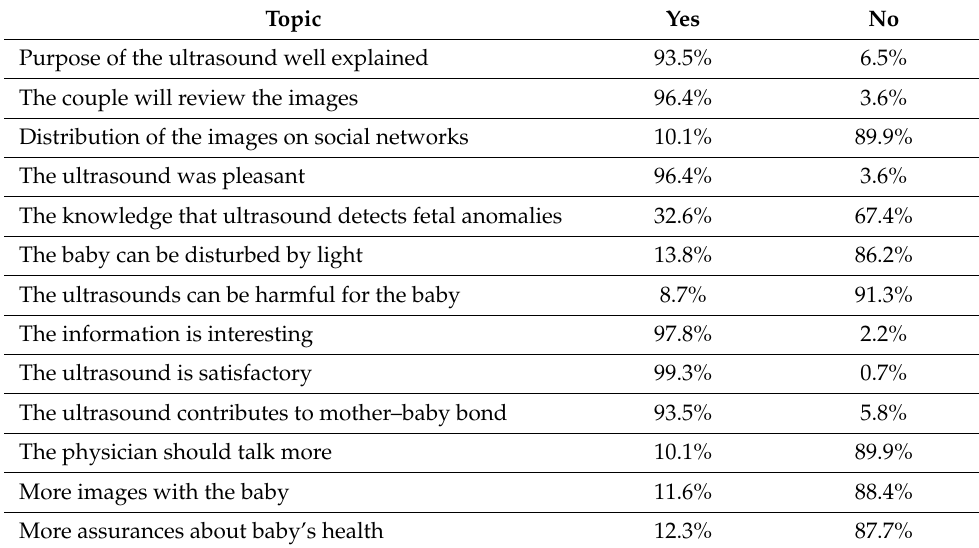
Table 2. Patients